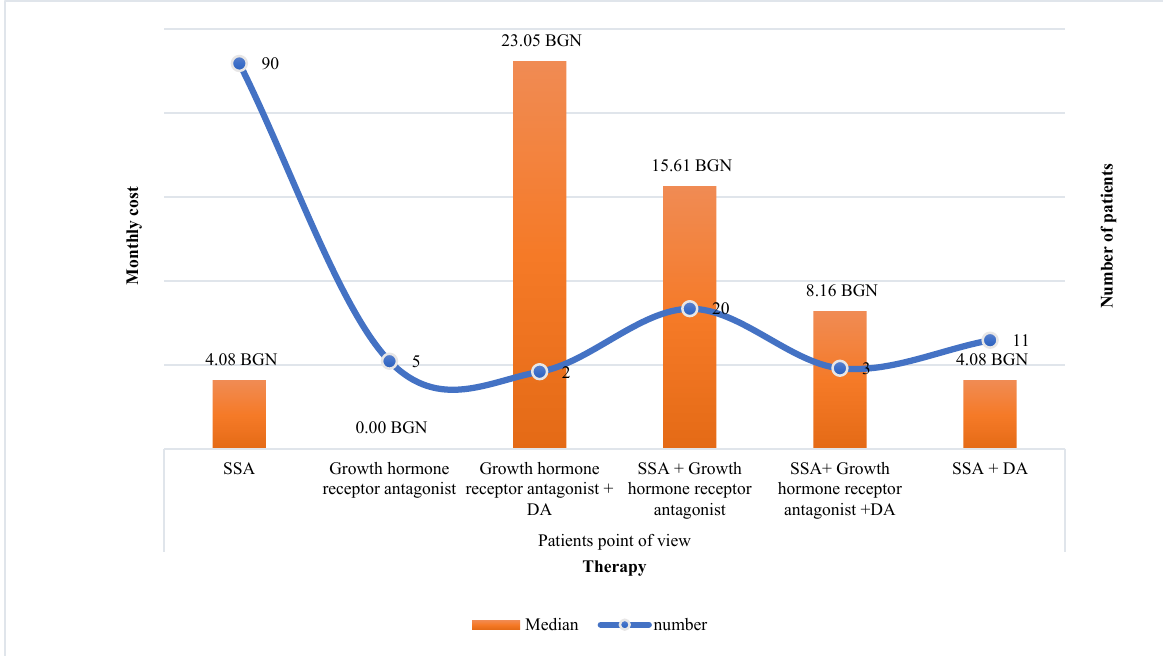
Figure 3. Co-payment for acromegaly therapy per month per patient .